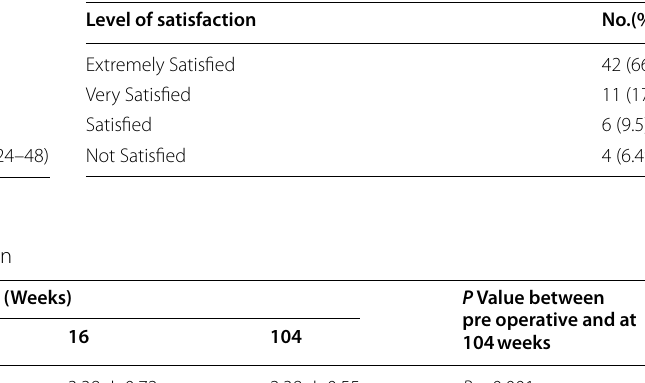
Table 3 Overall Satisfaction of All